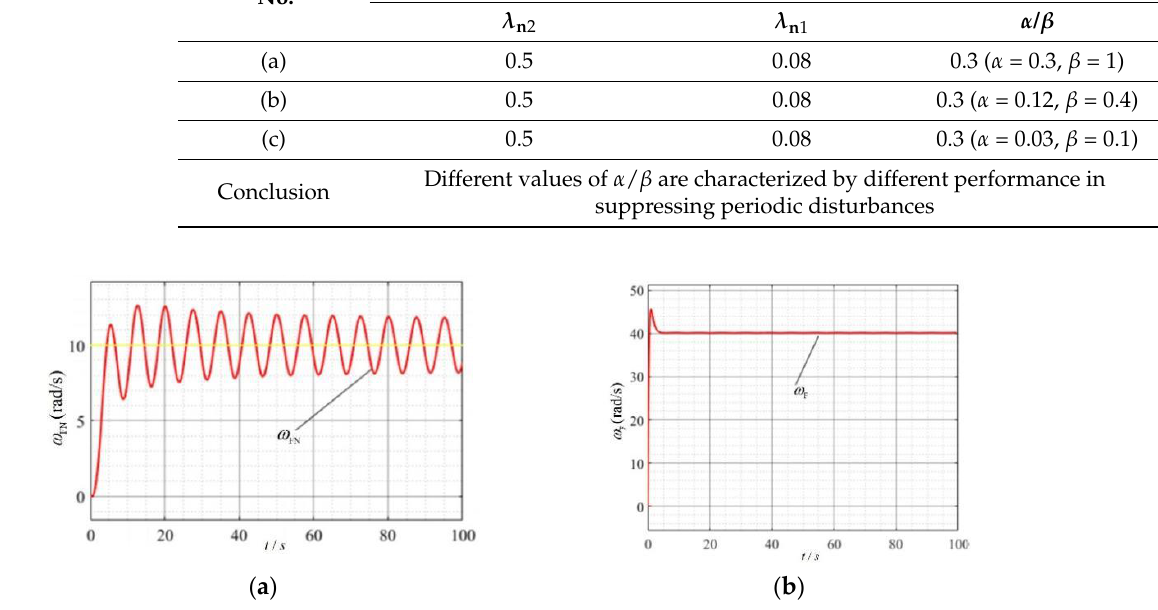
Table 6. Two schemes and conclusions of periodic perturbation. No.